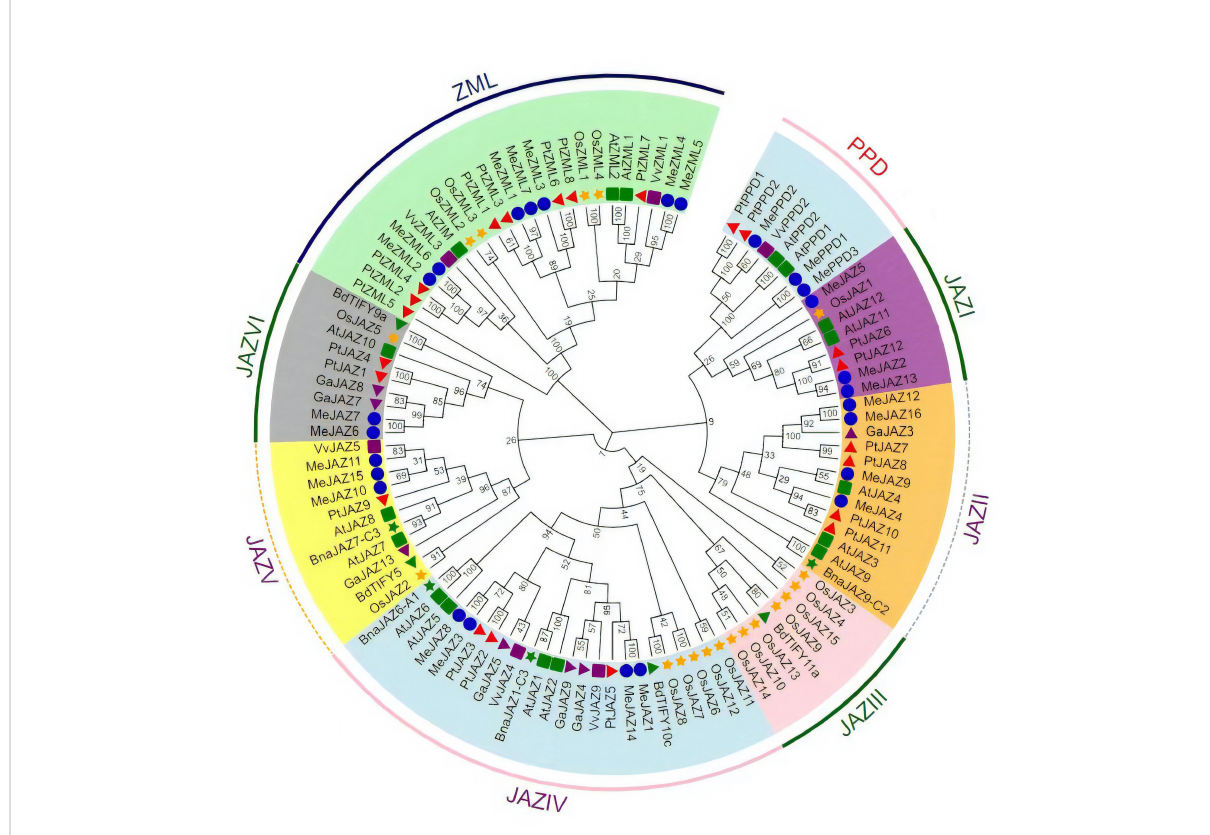
FIGURE 1 Phylogenetic tree of the TIFY proteins predicted in cassava and those previously identi fi ed in Arabidopsis , rice, Populus trichocarpa , Gossypium arboretum, Vitis vinifera, Brachypodium distachyon , and Brassica napus . The phylogenetic tree was constructed using the Neighbor-joining (NJ) method with 1000 bootstrap replications as implemented in MEGA7.1 from a TIFY protein sequence alignment. Different clade was distinguished by different color. Me, Manihot esculanta ; At, Arabidopsis thaliana ; Os, Oryza sativa ; Pt, Populus trichocarpa ; Ga, Gossypium arboretum ; Vv, Vitis vinifera ; Bd, Brachypodium distachyon ; Bna, Brassica napus